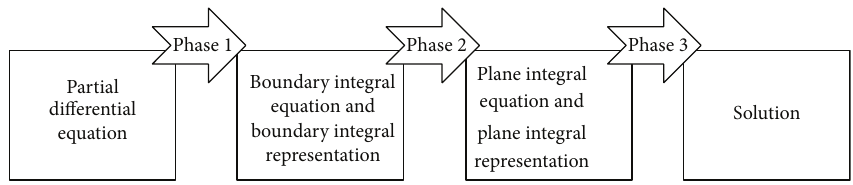
Figure 6: Diagram of the new